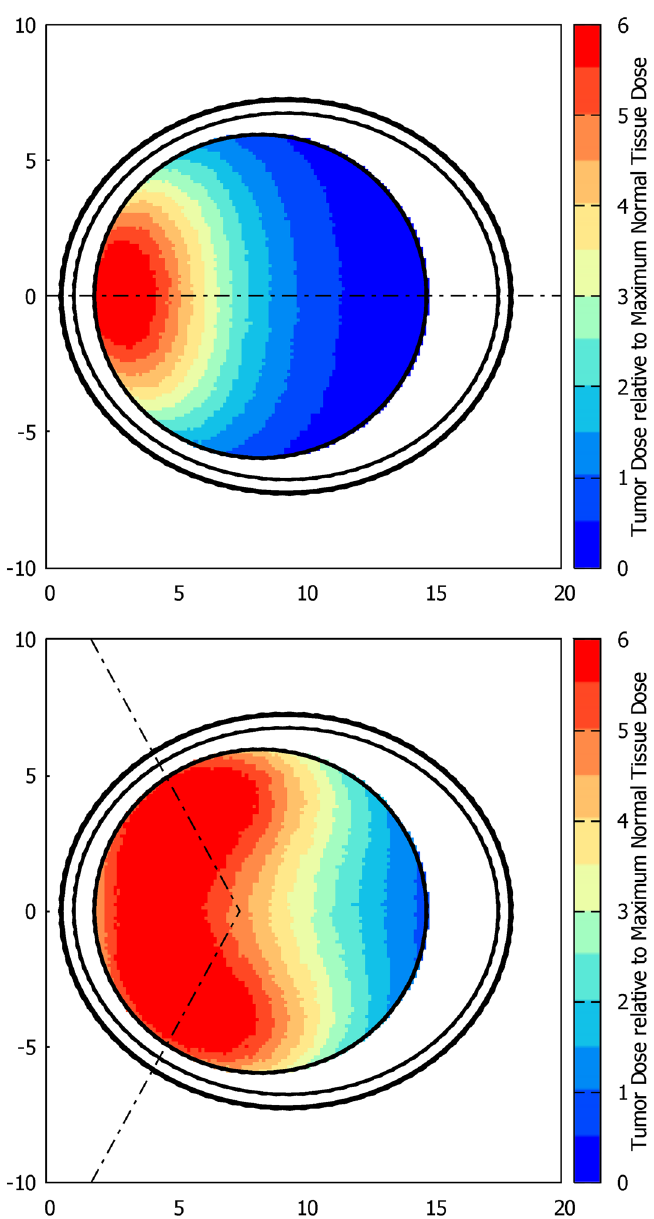
with respect to the head axial symmetry axis. Dashed-dotted lines indicate the beam axis for each irradiation field. The color scale is normalized to the maximum dose in normal